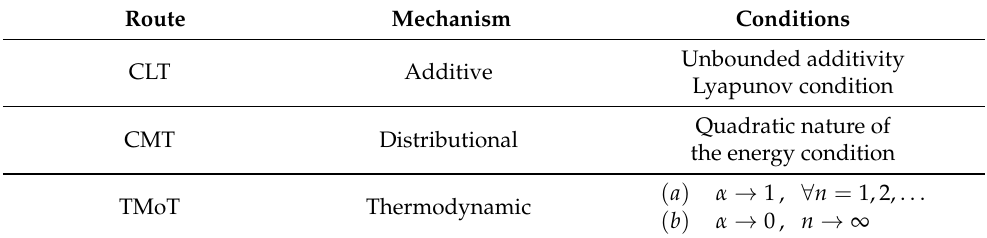
Table 1. Reviews of the routes to Gaussianity, from physical